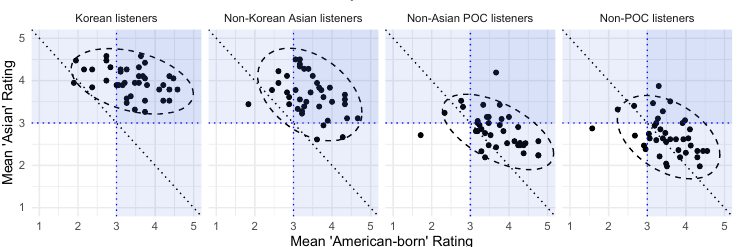
Figure 6. All four listener groups (Korean n = 19, non-Korean Asian n = 18, non-Asian POC n = 24, White n = 44) demonstrated a weak negative correlation between perceived American-born status and perceived Asianness. The correlation was weaker among Asian listeners than among non- Asian